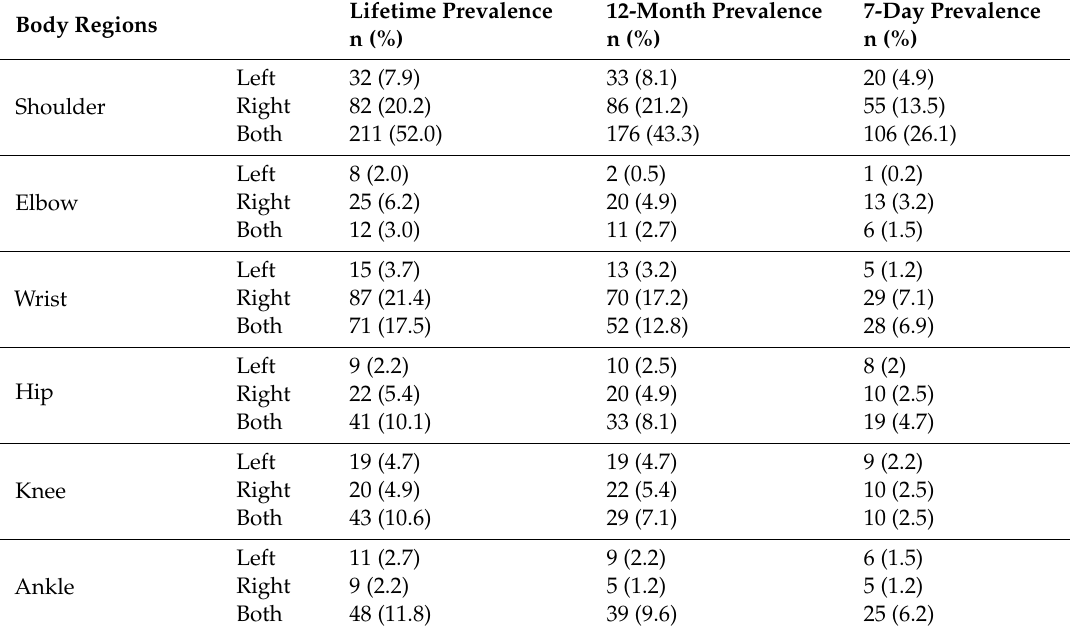
Table 3. Right and left MSDs’ prevalence of shoulder, elbow, wrist, hip, knee, and ankle shown in lifetime, 12-month, and seven-day prevalence.